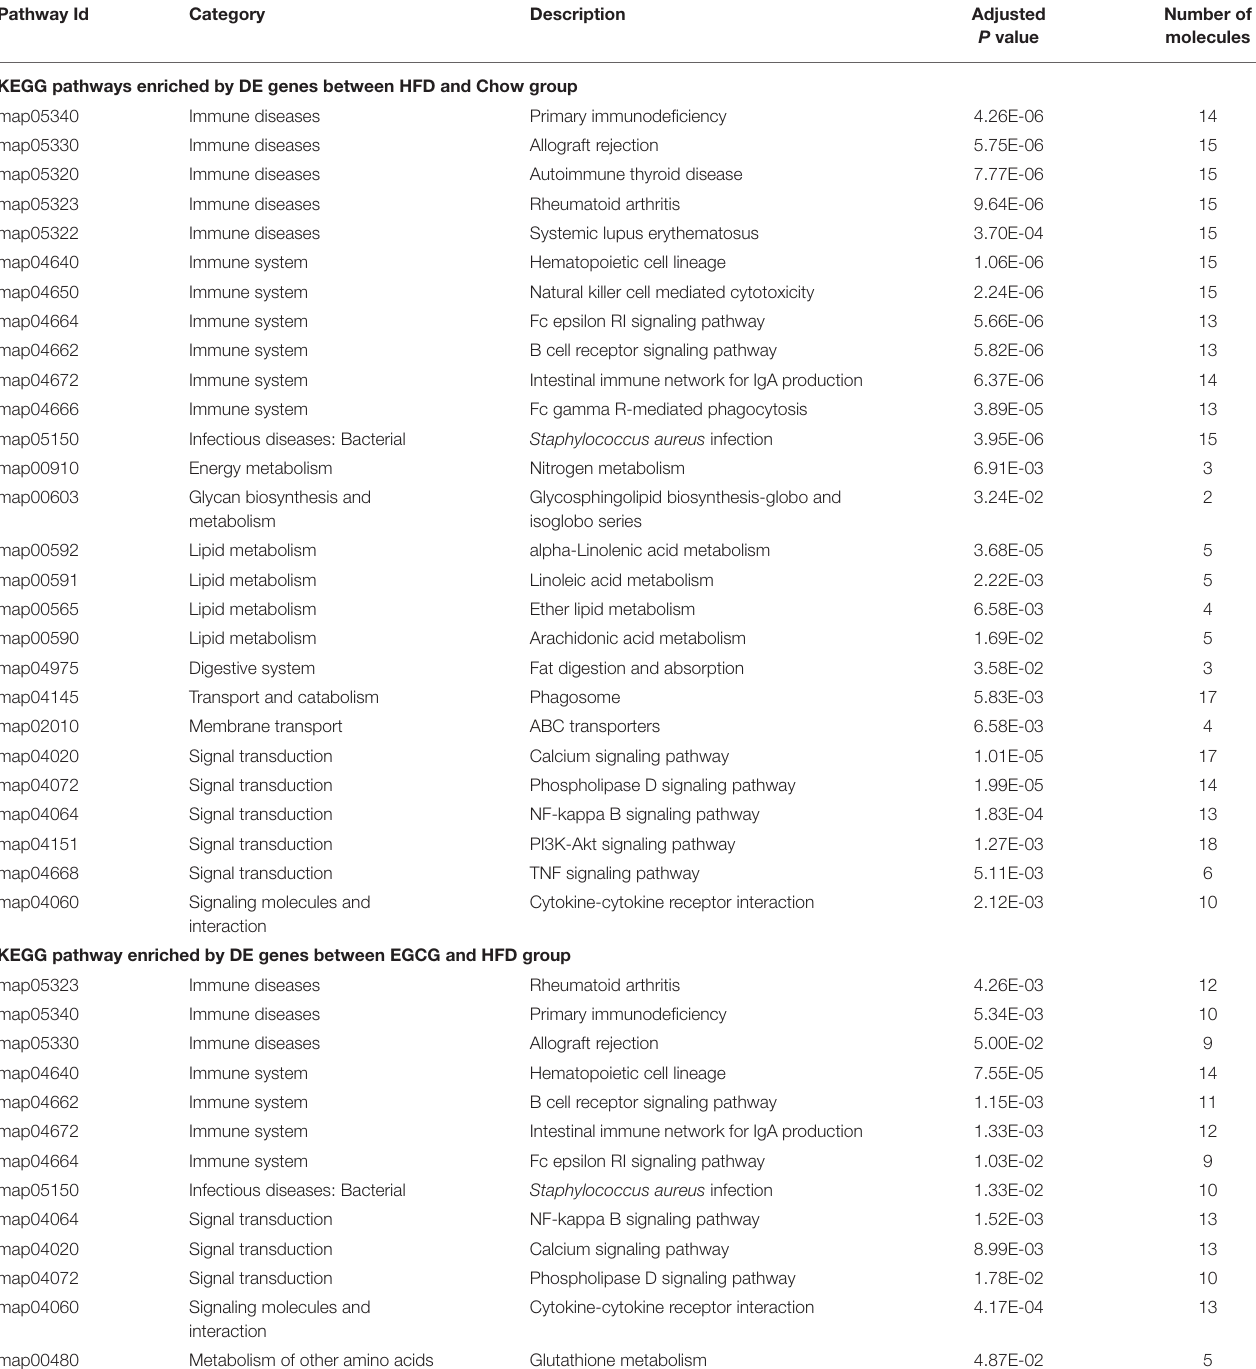
TABLE 1 | The Enriched KEGG pathway of differentially expressed genes among chow, HFD, and EGCG groups. Pathway Id Category